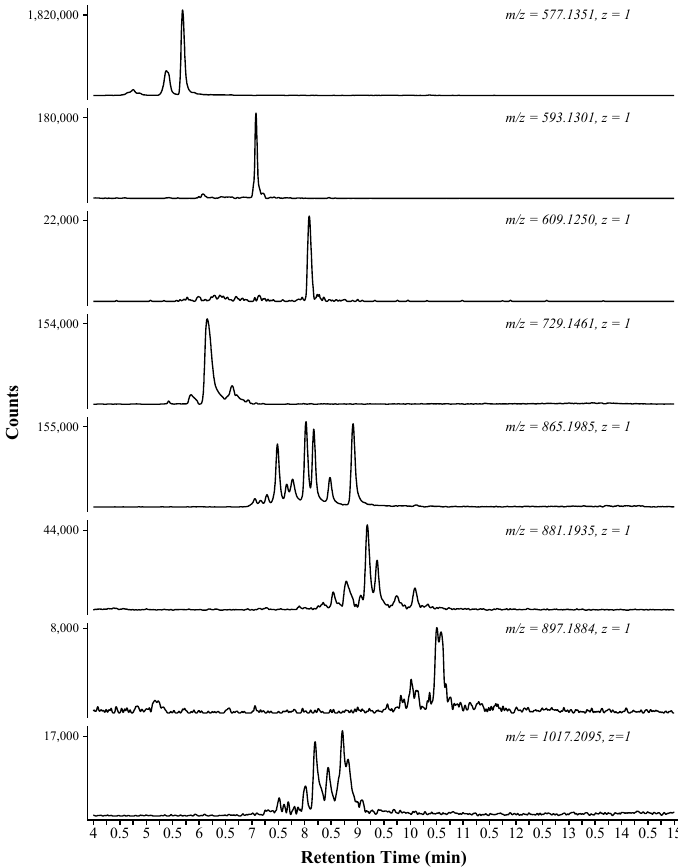
Figure 2. Selected Extracted Ion Chromatograms (EIC) for the eight-week maceration sample (Em8). The extracted mass and corresponding charge are indicated above each trace .